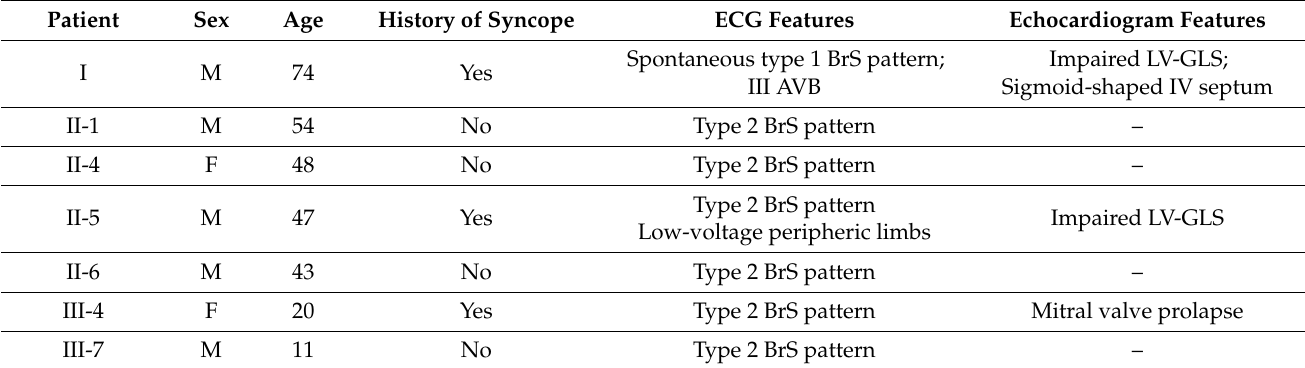
Table 2. Cardiac phenotypes of the members carrying the DLG1